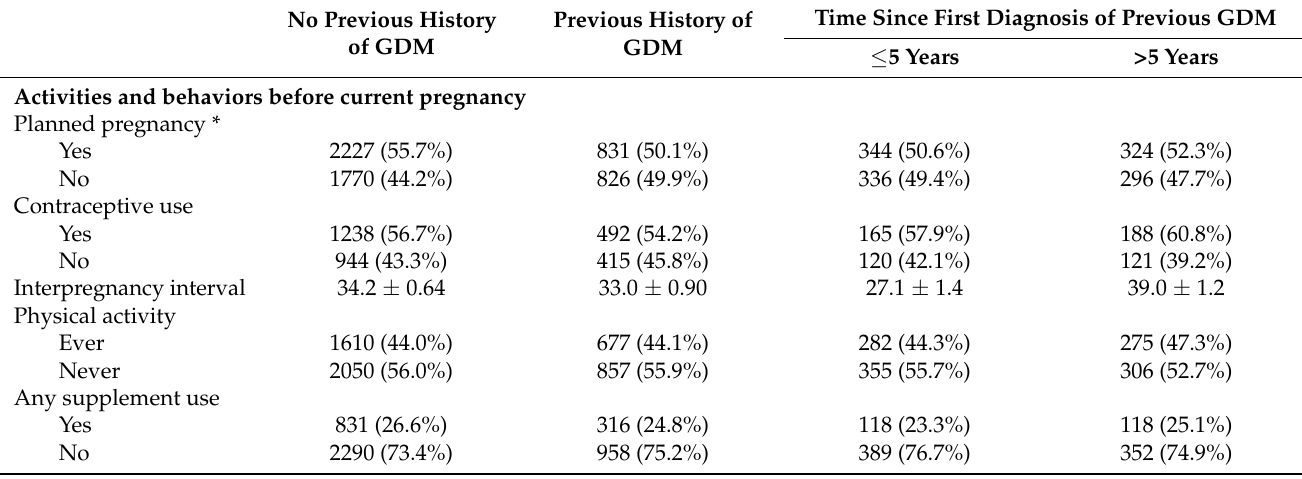
Table 2. Distributions of activities and behaviours before and during current pregnancy by history of previous GDM status amongst 5738 pregnant women in Al Ain, UAE. The Mutaba’ah